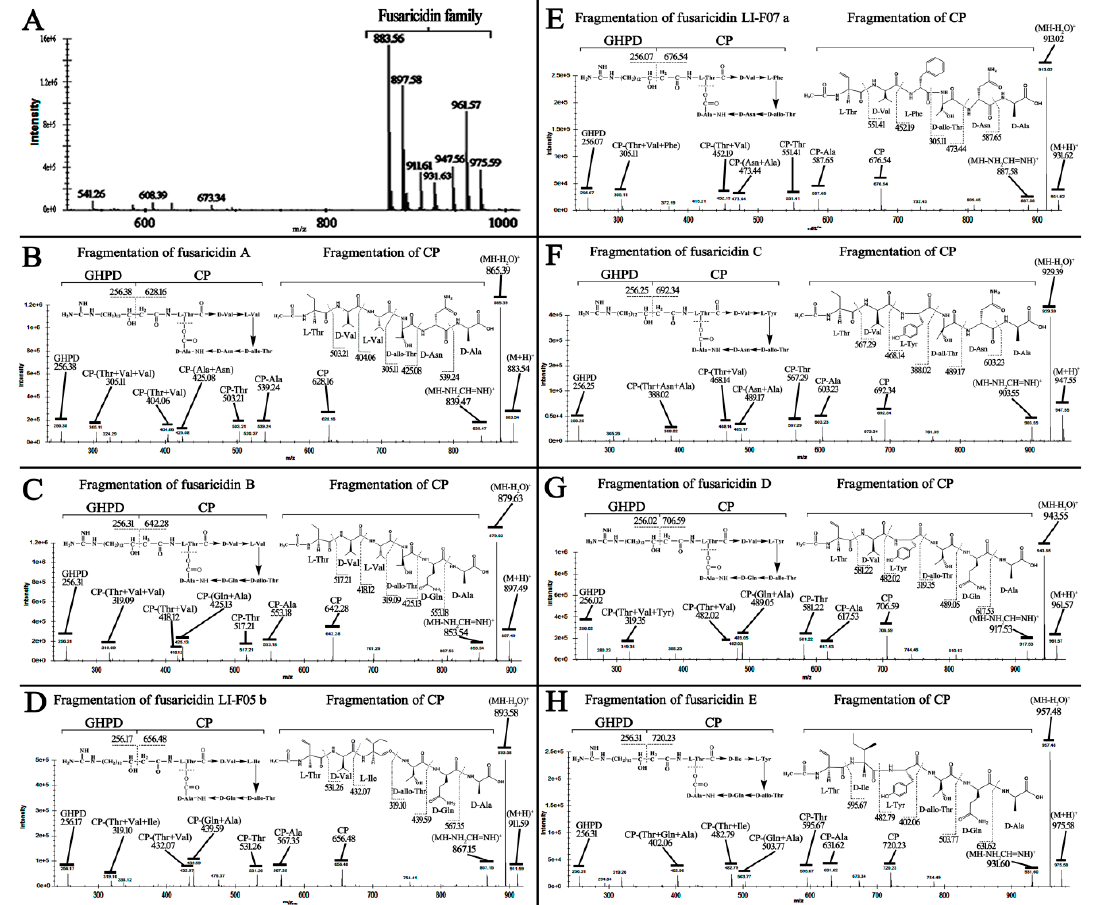
Figure 3. LC ‐ MS analysis of fusaricidins extracts from P. polymyxa WLY78 ( A ). The fragmentation patterns of fusaricidin structures when using m / z 883.56 ( B ), 897.58 ( C ), 911.61 ( D ), 931.63 ( E ), 947.56 ( F ), 961.57 ( G ), and 975.59 ( H ) as a precursor ion through MS–MS fragment ion analysis, respectively.